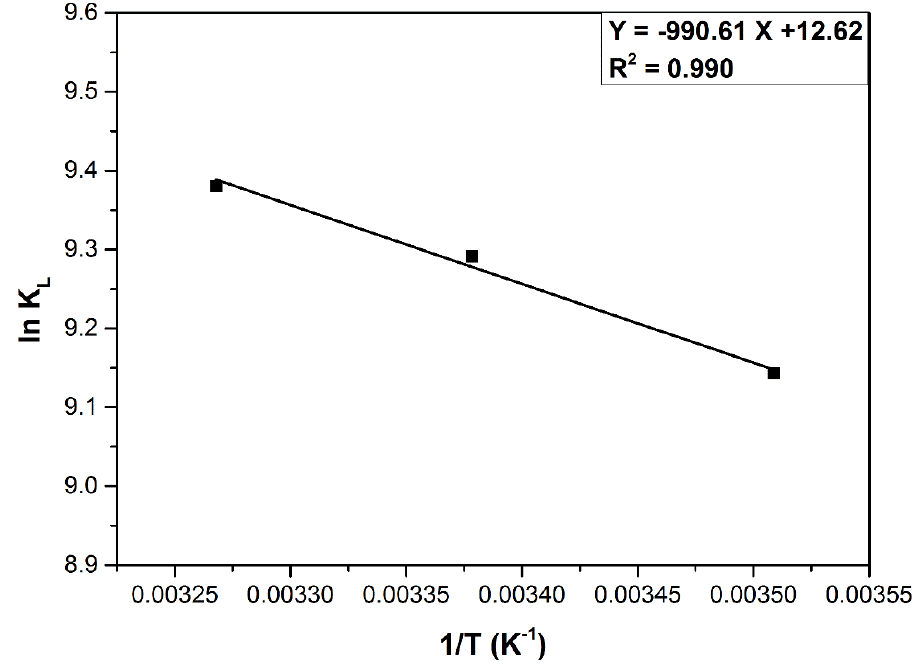
Figure 8. Plot of ln K L vs. 1/T for MB adsorption on DBPH powder.